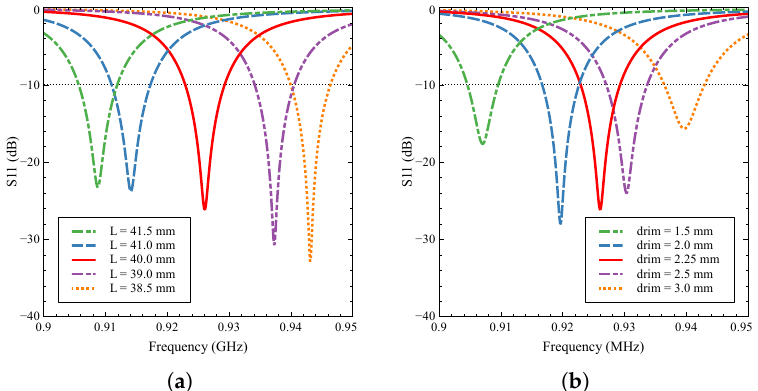
Figure 7. Simulated reflection coefficient at low-frequency band with variations of ( a ) the length of metal rim (L) and ( b ) open gap